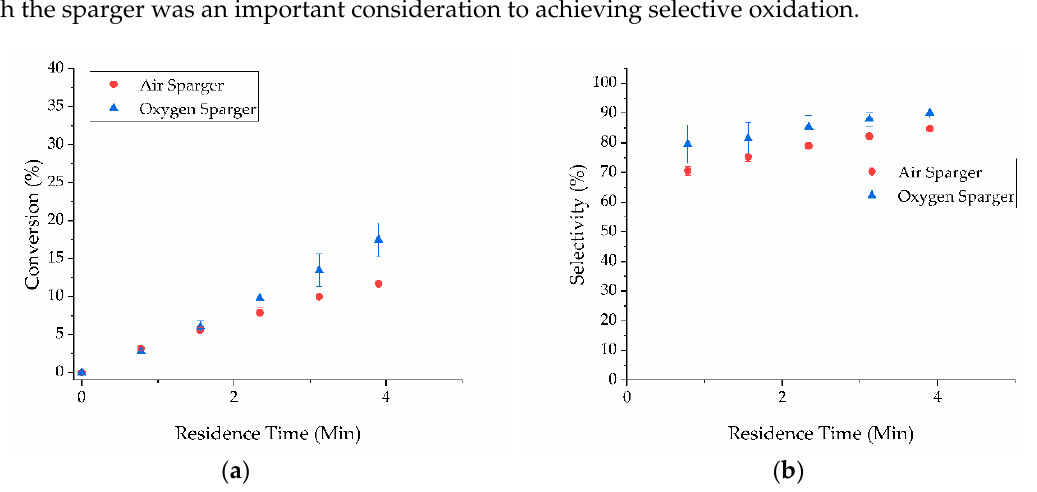
Figure 4. ( a ) Conversion of benzyl alcohol; ( b ) selectivity to benzaldehyde for the sparger modified X-Cube™ and external pump system for both air (red circles) and pure oxygen (blue triangles) at 9.7 bar.